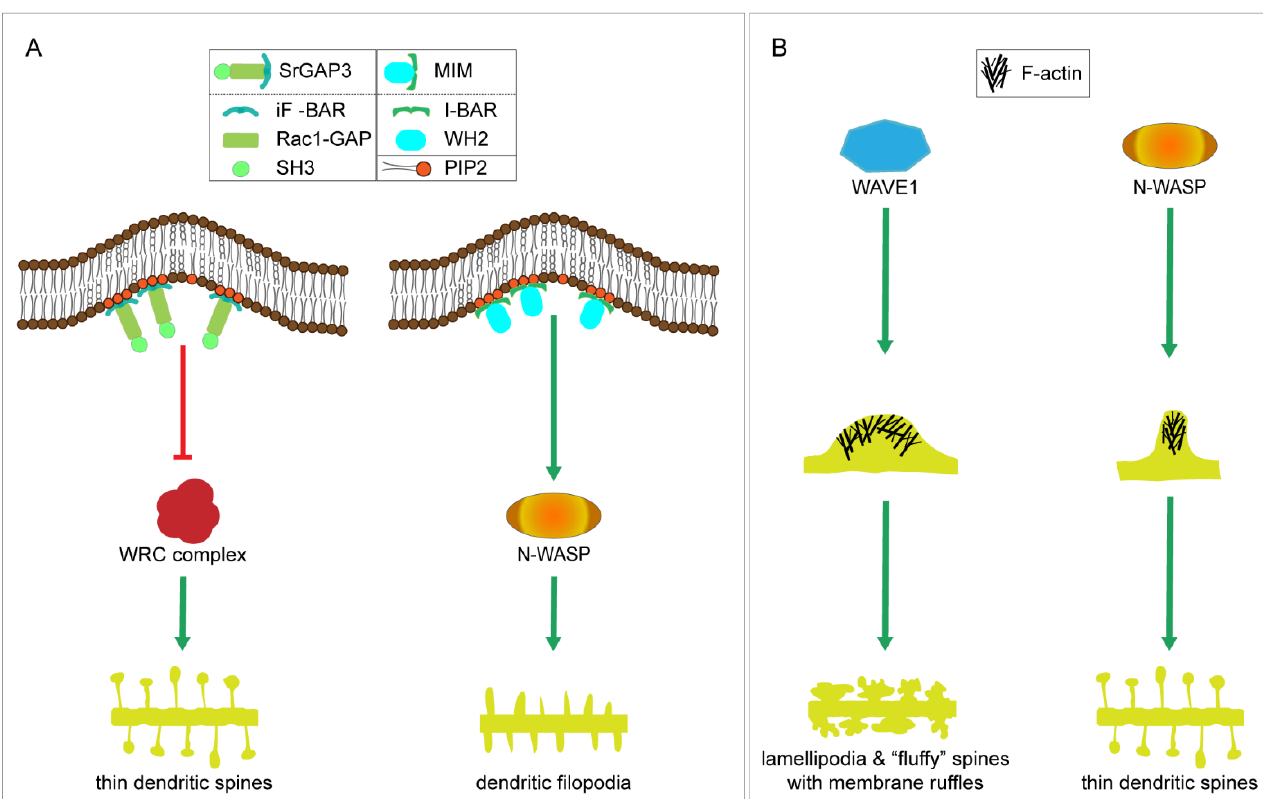
Figure 1. Roles of SrGAP3, MIM/Mtss1, WRC/WAVE1 and N-WASP in formation of dendritic protrusion. ( A ) Comparison between SrGAP3- and MIM/Mtss1-mediated dendritic spine initiation mechanisms. Both bind PI(4,5)P2 and curve the membrane negatively. SrGAP3 regulates WRC activity, possibly inhibiting its activity, whereas MIM/Mtss1-induced spine initiation involves N-WASP. SrGAP3 overexpression results in thin spines, whereas MIM/Mtss1-induced protrusions have a finger-like morphology. ( B ) Comparison between WAVE1- and N-WASP-mediated actin polymerization. Both WAVE1- and N-WASP-activated Arp2/3-complex-induced actin polymerization plays a significant role in neuron morphogenesis. WAVE1 mediates the formation of broad sheet-like actin structures, such as lamellipodia whereas N-WASP facilitates focal actin polymerization. We hypothesize that WAVE1 is required mainly for actin polymerization for spine heads and N-WASP-induced polymerization is important for dendritic filopodia formation.